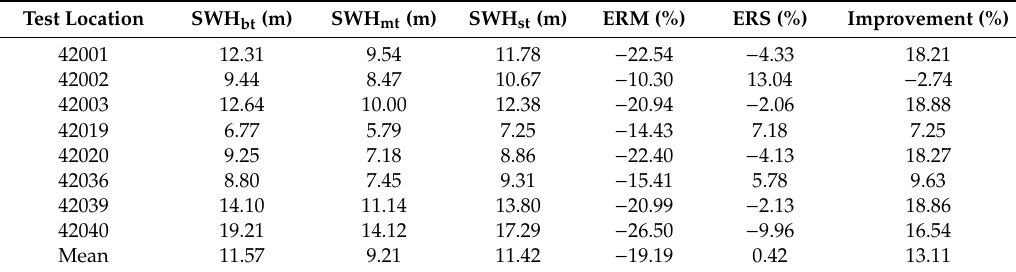
Table 5. Gulf of Mexico: results for T R = 50 years.